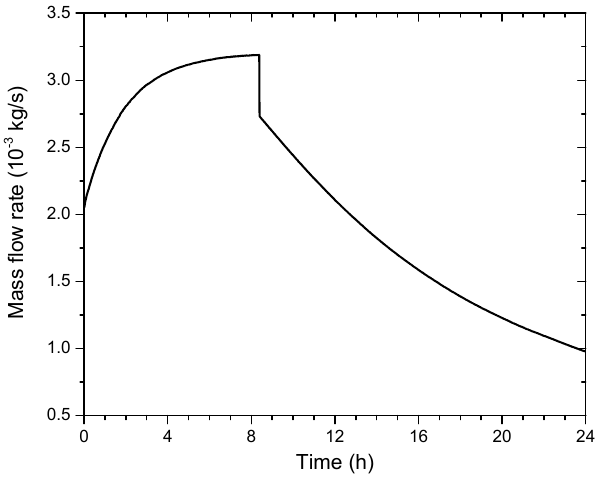
Figure 9. The change of air mass flow rate during the charging and discharging processes.